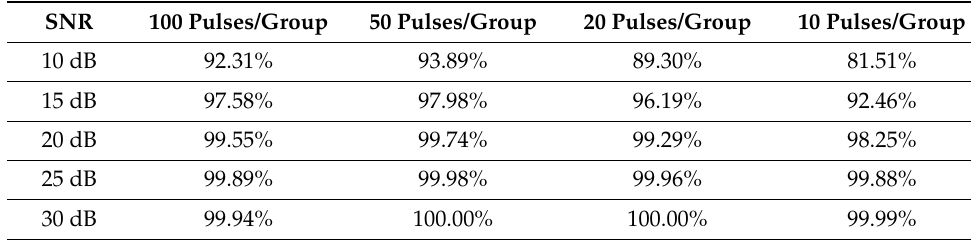
Table 4. Accuracy with various number of pulses in each group.